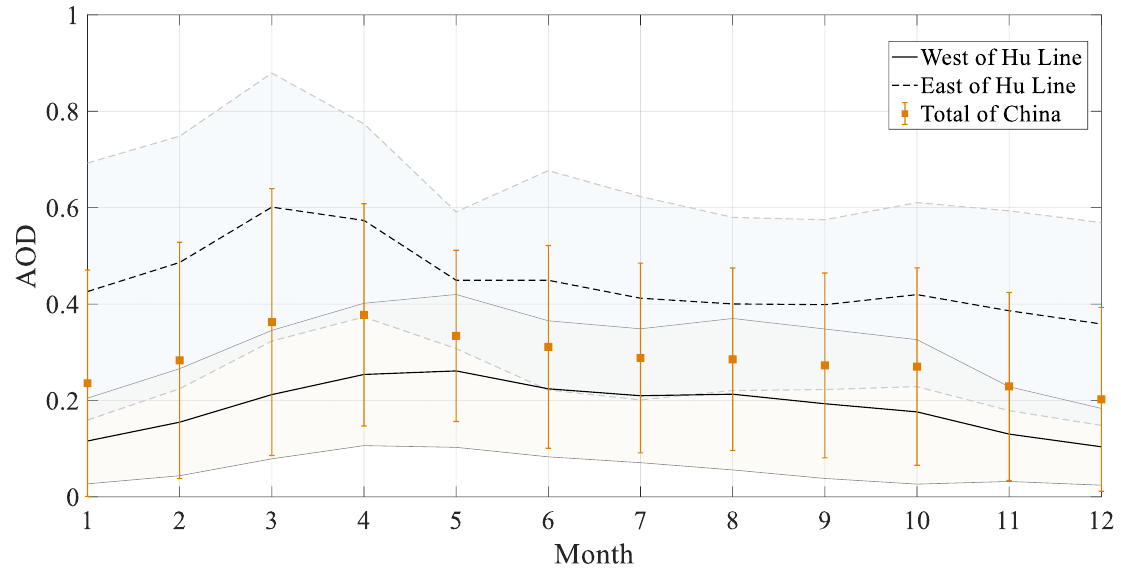
Figure 8. Monthly average and standard deviations of AOD values across 11 years from 2010 to 2020 in the Eastern and Western regions of the Hu Line.